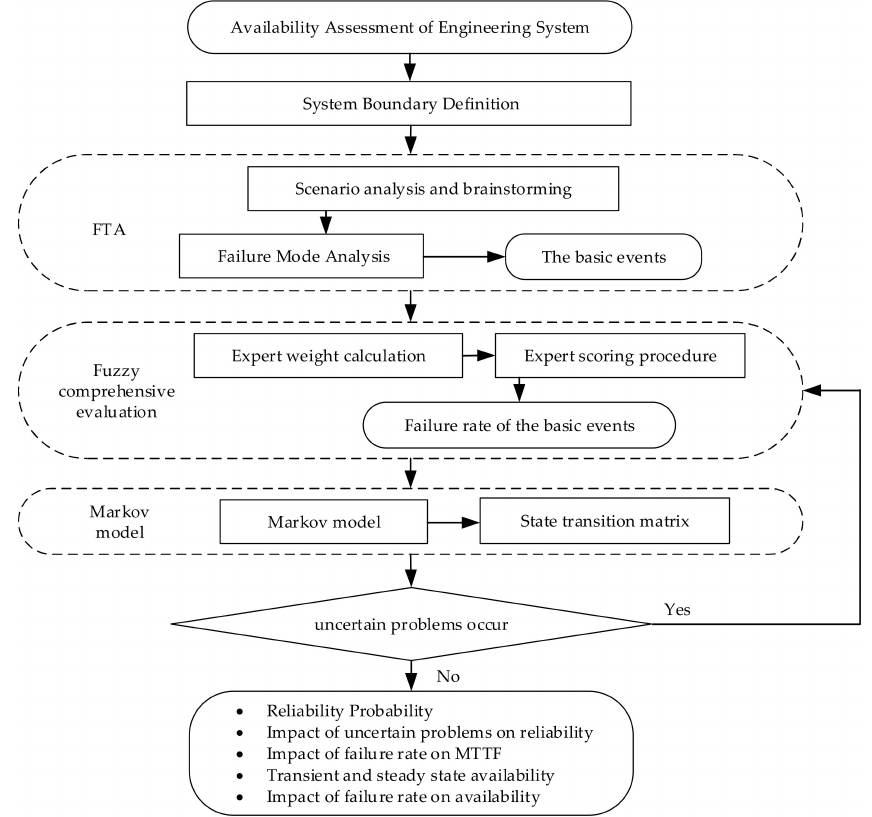
Figure 1. Fuzzy Markov integration framework. FTA: Fault Tree Analysis; MTTF: Mean time to